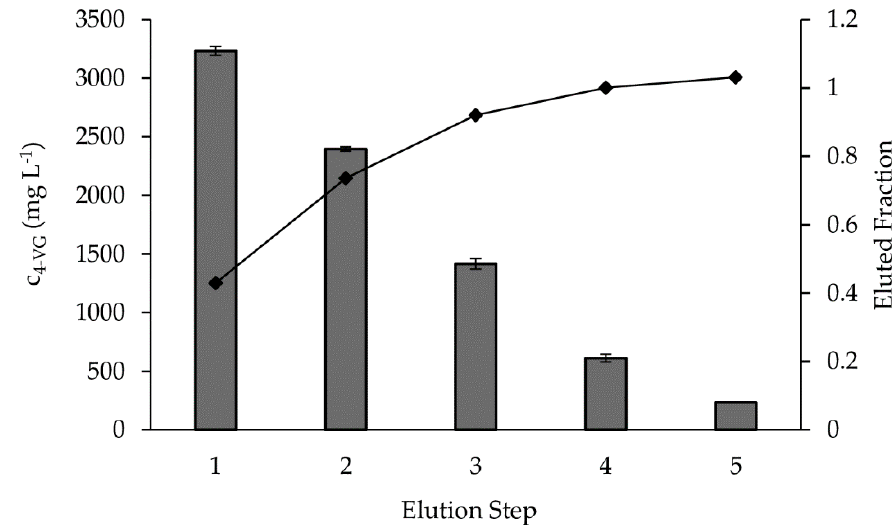
Figure 4. Elution of 4-VG from XAD4 after the process. Five consecutive elution steps using 200 mL 96% undenatured ethanol in total were applied, containing decreasing product concentrations (grey bars). The eluted mass was accumulated in each elution step and set in relation to the overall produced product mass of about 306 mg (Figure 3) (black diamonds). All samples were measured in triplicates.